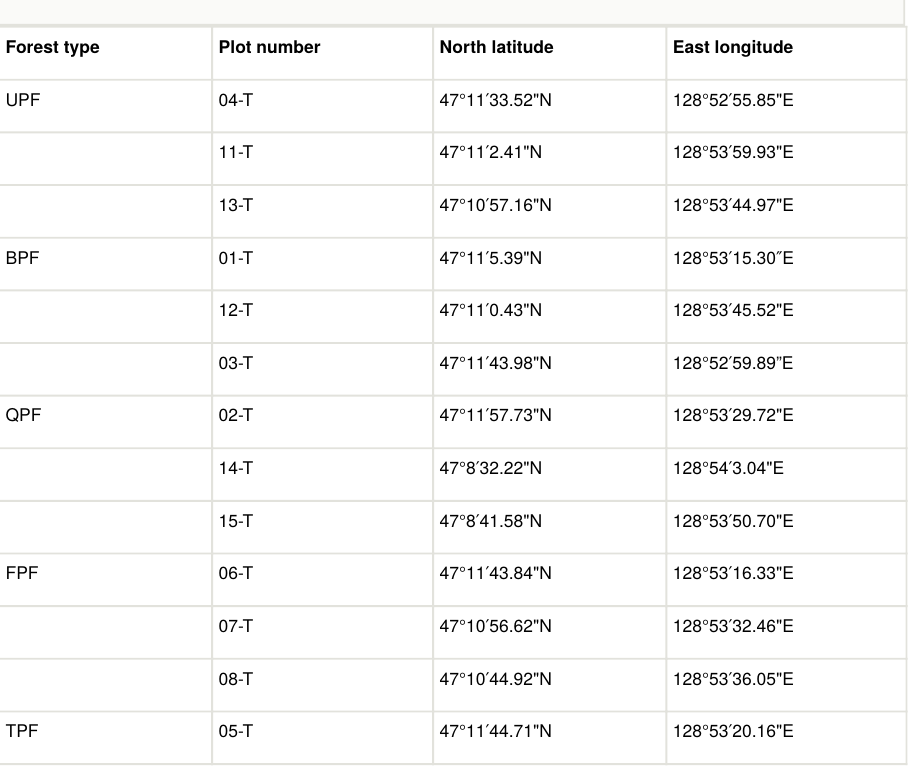
Geographical coordinates of quadrats of fi ve forest types in Liangshui National Natural